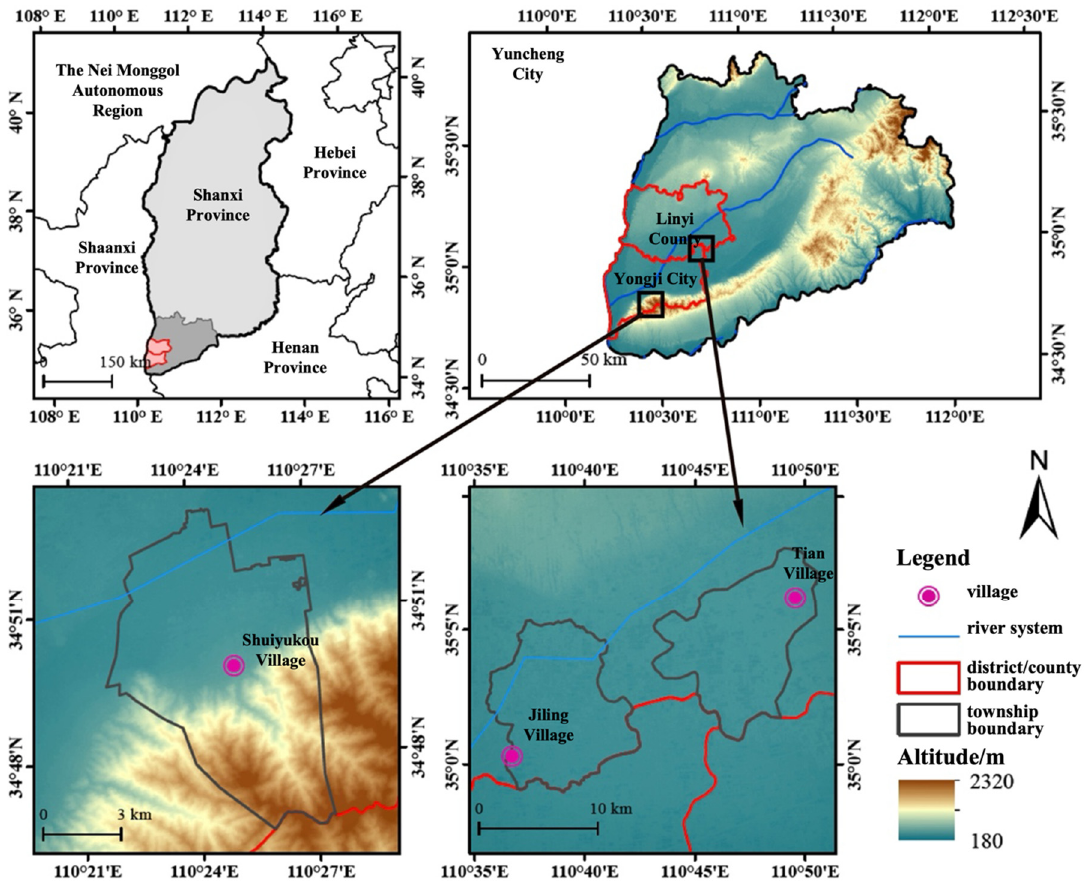
Figure 2. Location map of the study area.